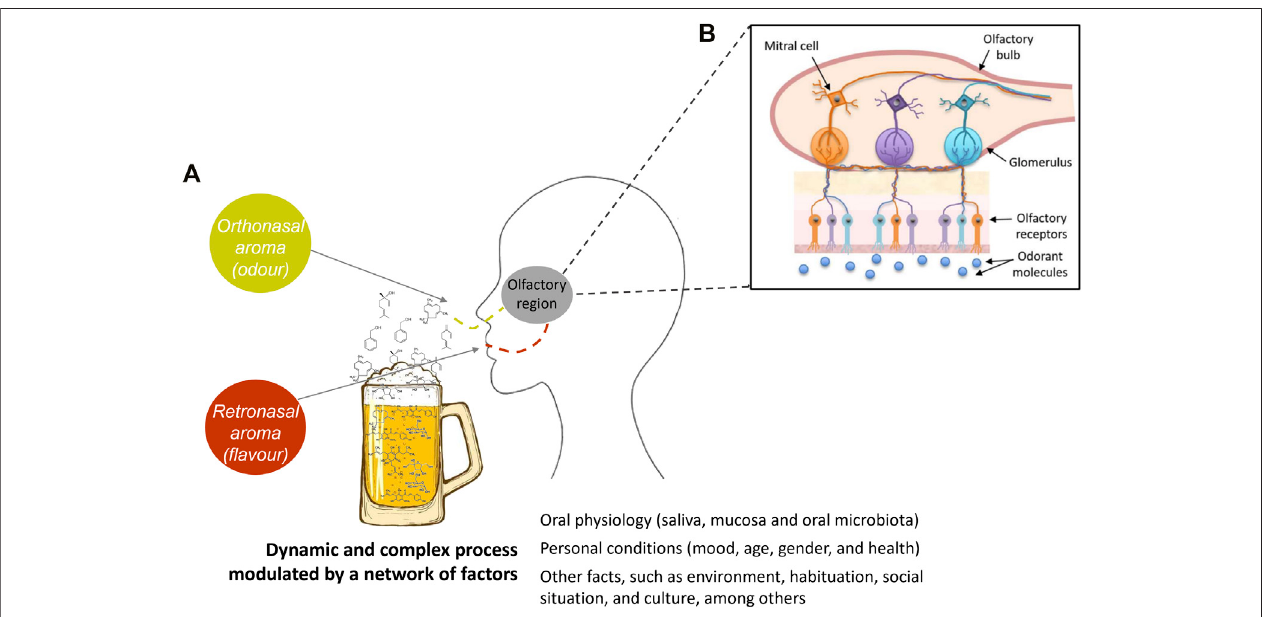
FIGURE 2 | Simpli fi ed schematic representation illustrating that odorant molecule release and aroma perception are very complex processes that cover several variables, such as volatile and non-volatile composition of food, and oral physiology-related factors, among others. The odorant substances are perceived by the odor receptor sites of the smell organ. Figure adapted from Kotecha et al.